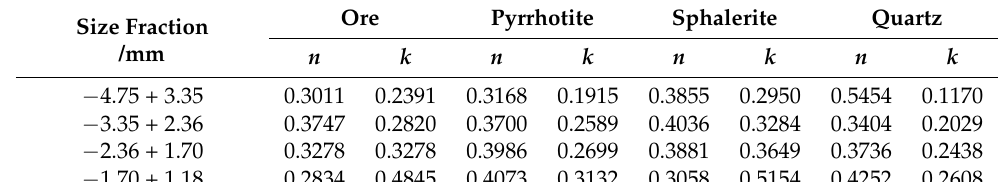
Table 1. Grinding kinetic parameters n and k of different size fraction.